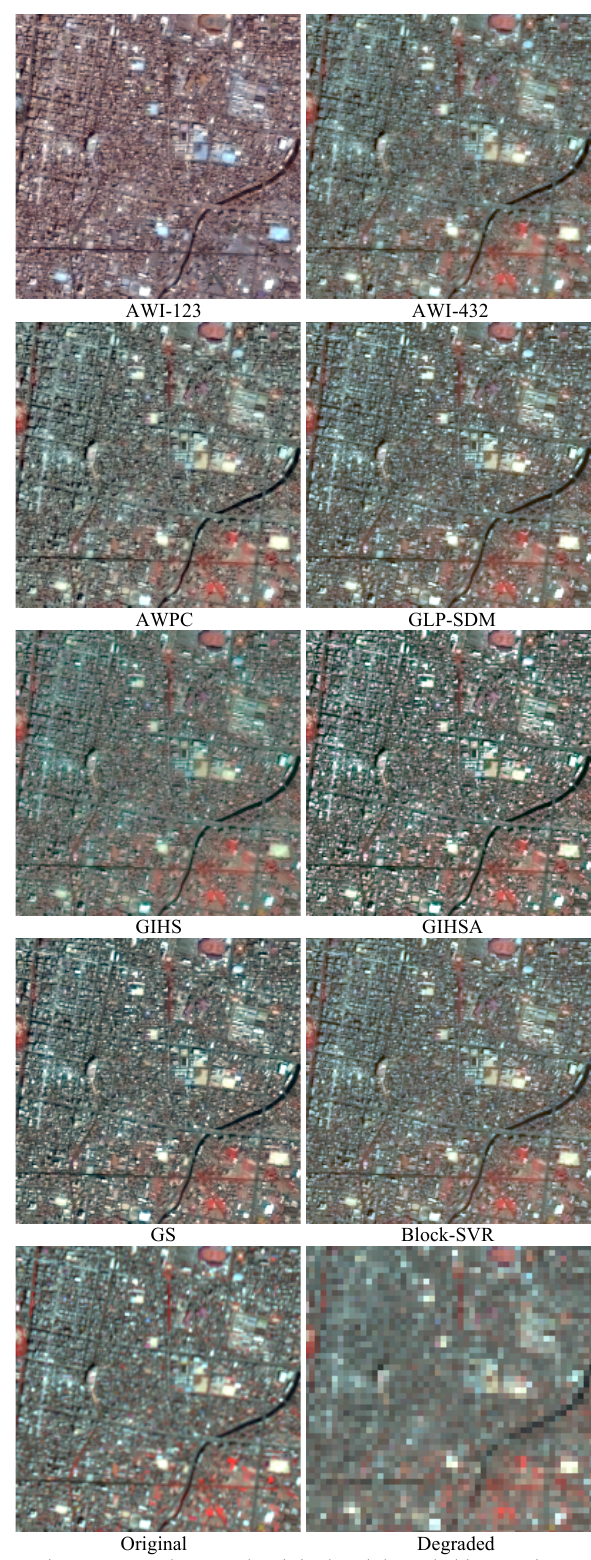
Degraded Figure 2. Pansharpened, original and degraded images in an urban